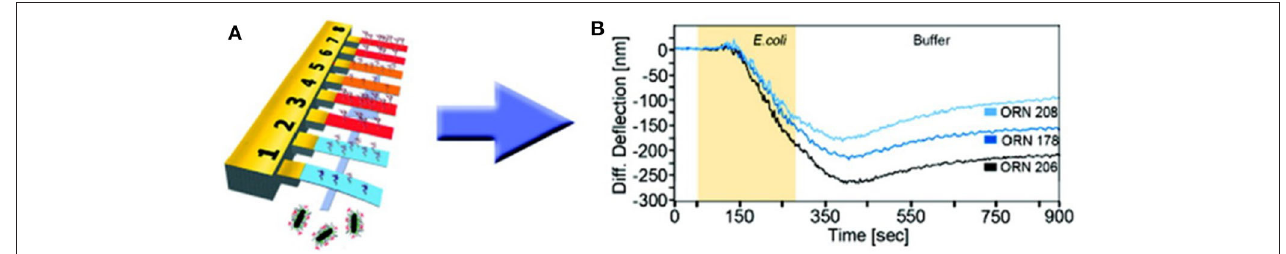
FIGURE 3 | Bacteria detection with static mode nanomechanical sensors. (A) Schematic representation of a gold-coated silicon cantilever array sensor functionalized with self-assembled monolayers of glycans. (B) Discrimination of three different E. coli strains by differential deflection of the cantilever sensors. Reprinted from Mader et al. (2012) with permission from the American Chemical Society.